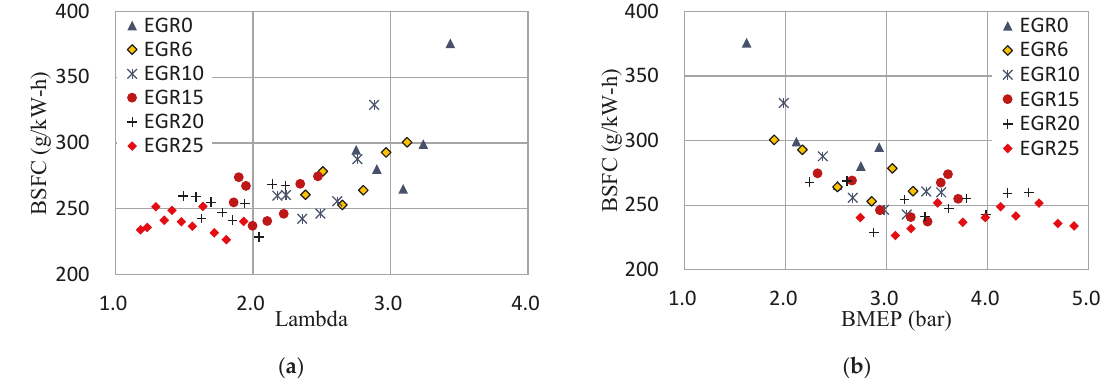
Figure 6. Brake specific fuel consumption with respect to: ( a ) Lambda; ( b ) BMEP.